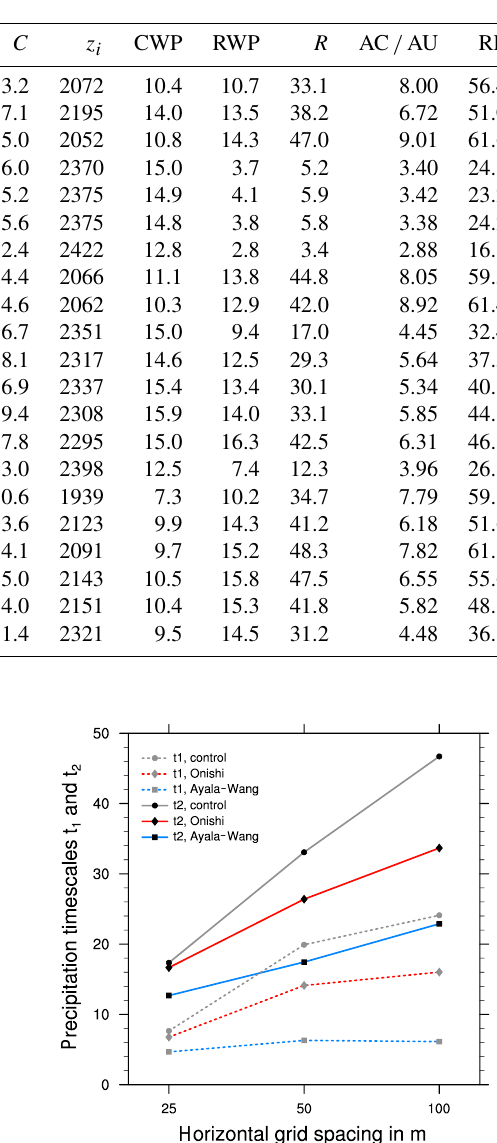
Table 3. As previous table but for the simulations to investigate the resolution dependency at N c = 50cm − 3 .